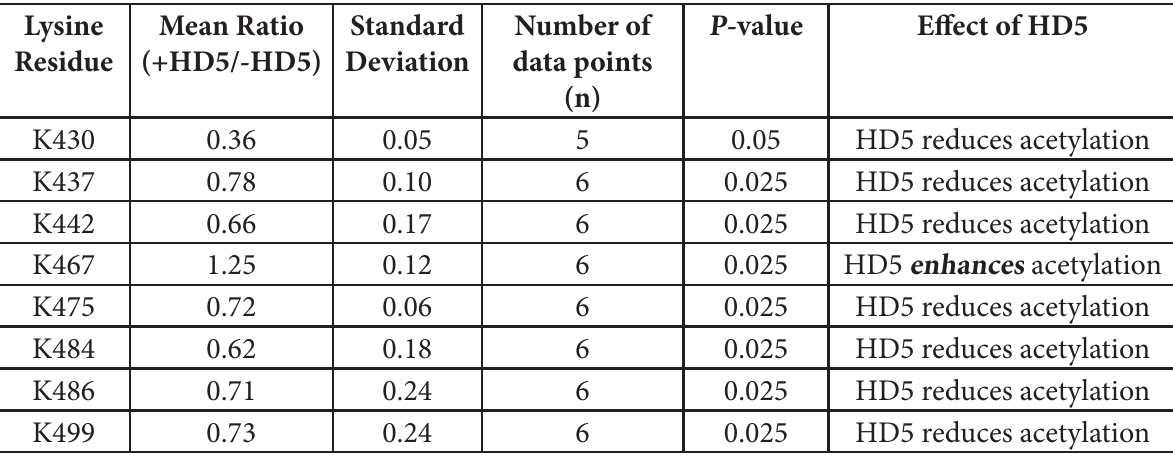
Table 2. Mass spectrometry detected lysine acetylation sites of L1 protein affected by the presence